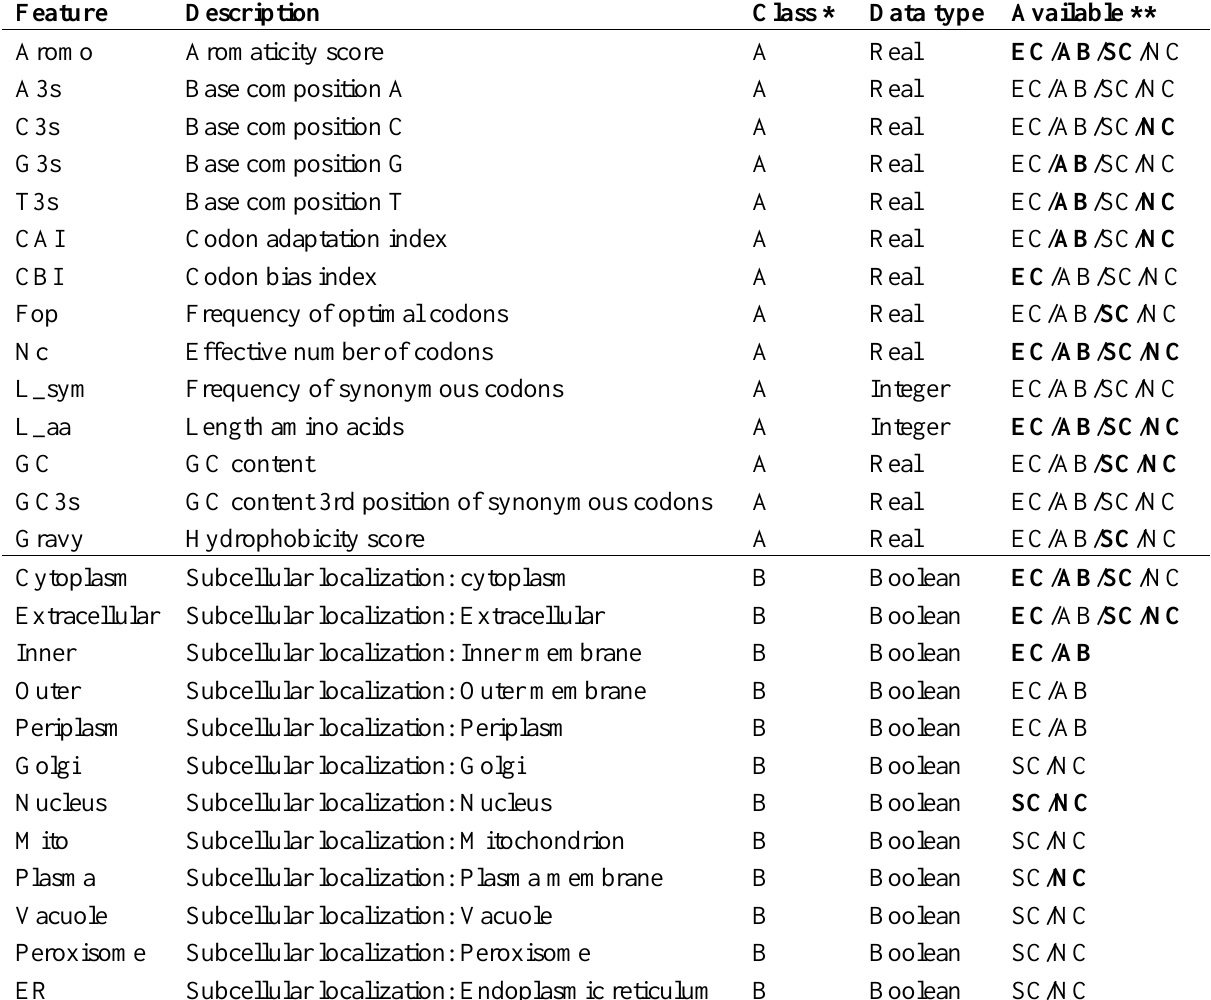
Table 1. Thirty-five considered